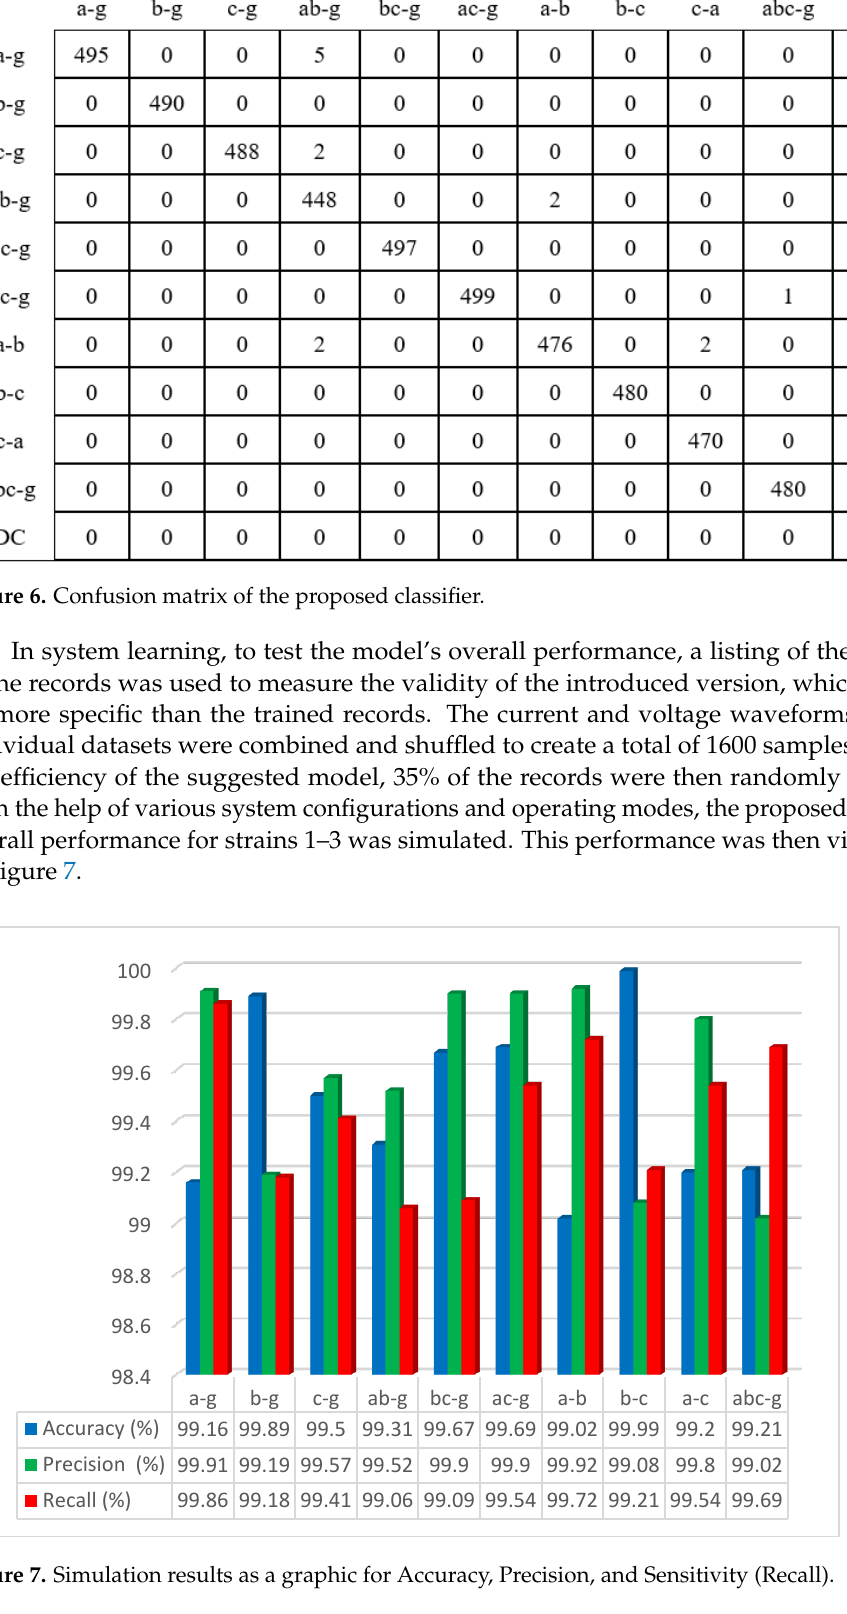
Figure 7. Simulation results as a graphic for Accuracy, Precision, and Sensitivity (Recall).